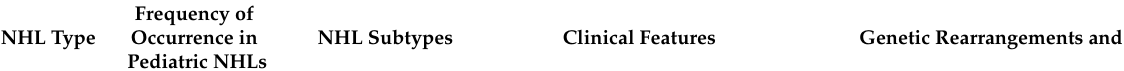
Table 1. Characteristic of main pediatric NHL types